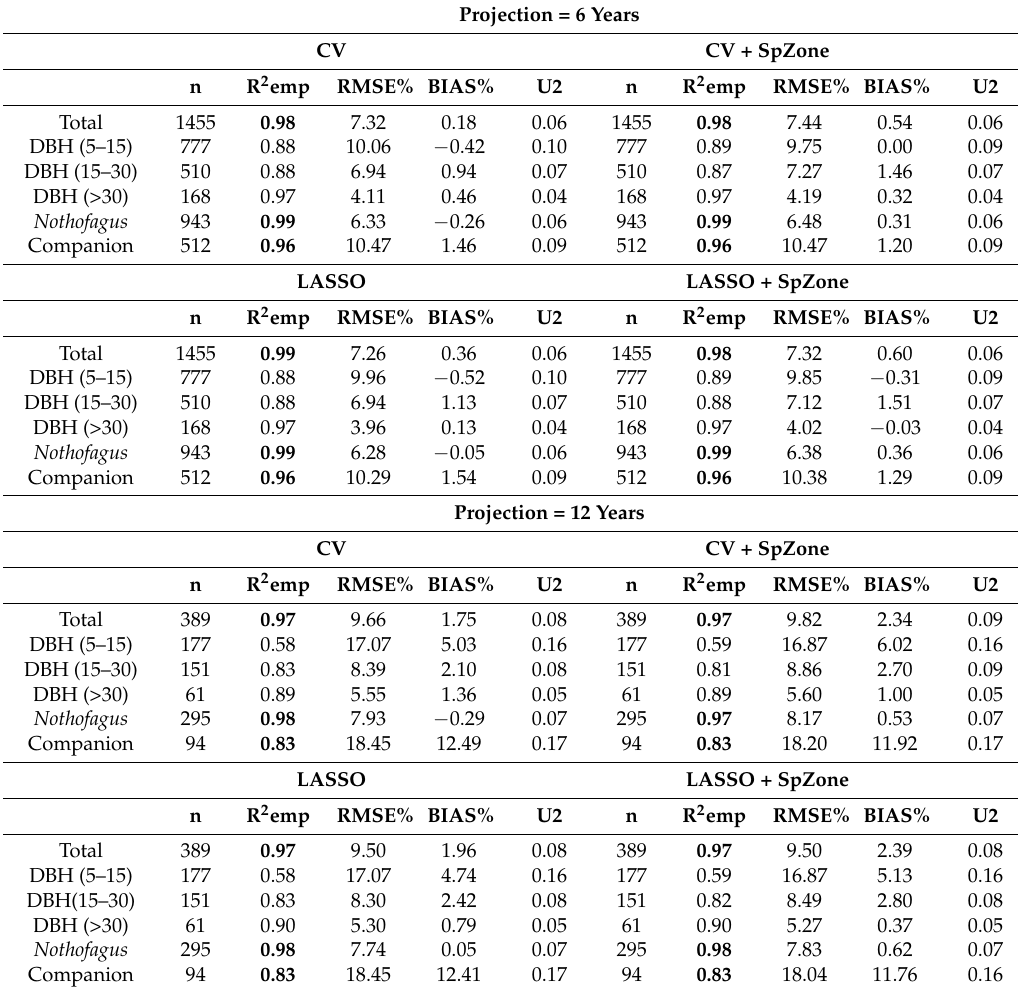
Table 5. Projection goodness-of-fit statistics for diameter at breast height (cm) using a period of 6 and 12 years based on the validation database. Values in bold correspond to best